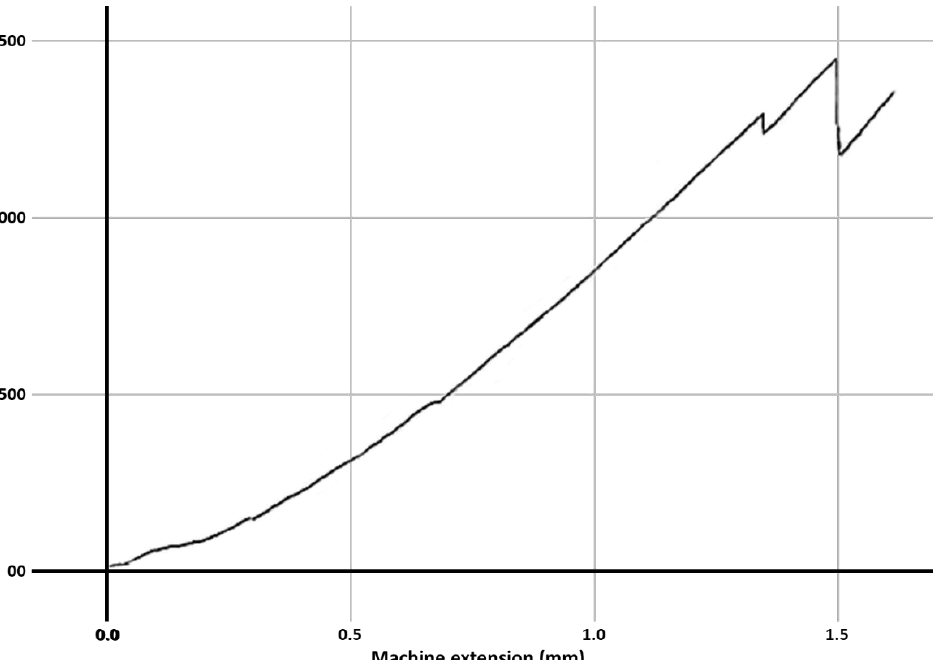
Figure 3. The maximum value of the force at which the most resistant molar from Group B failed.